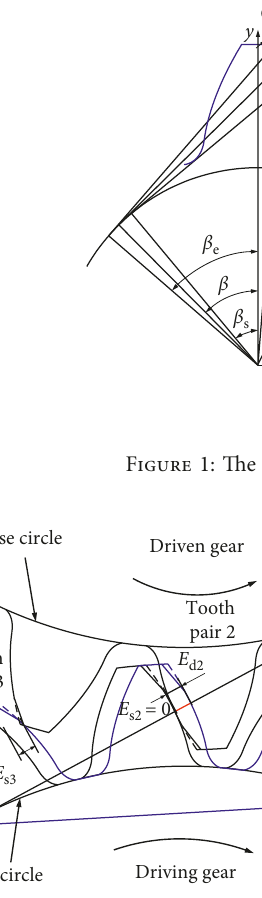
Figure 2: Diagram of a meshing gear